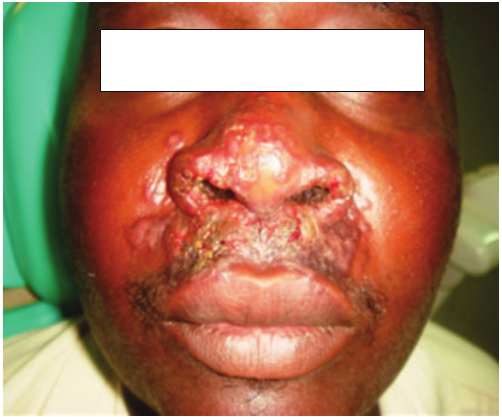
Figure 8: Shows patient no. 2 at presentation. There are papules and plaques over the nose and the lip.